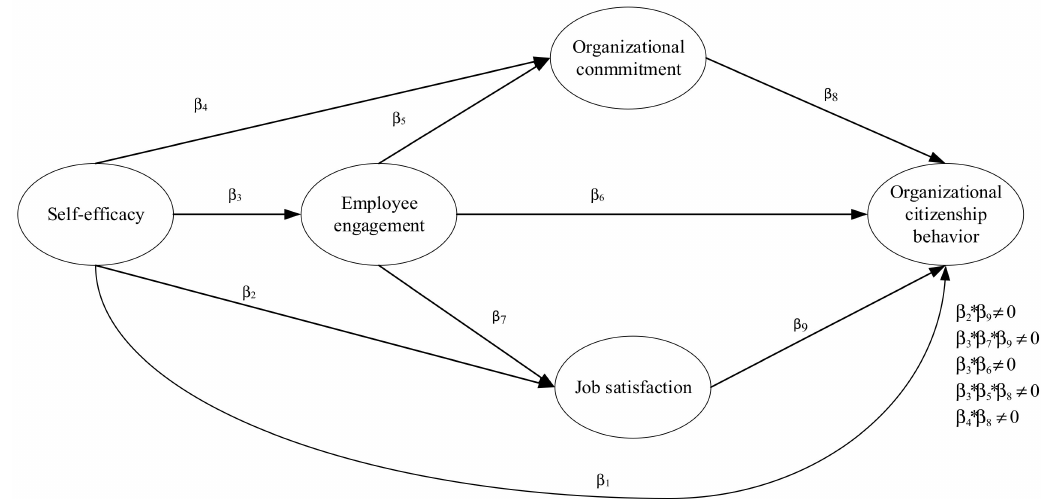
Figure 1. The influence model of self-efficacy on organizational citizenship behavior with mediators of employee engage- ment, organizational commitment and job